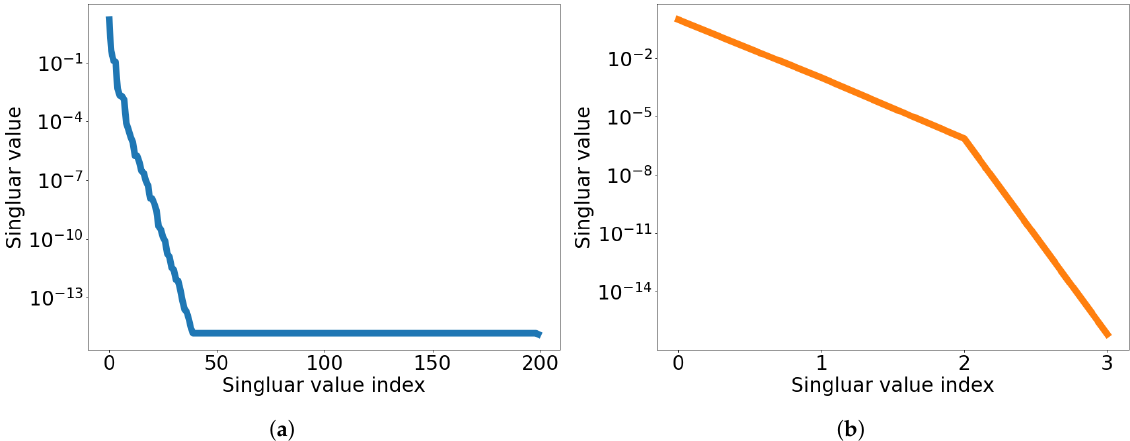
Figure 3. 2D linear diffusion equation. Graph of singular value decay. ( a ): Singular value decay of solution snapshot, ( b ): Singular value decay of temporal snapshot for the first spatial basis vector.